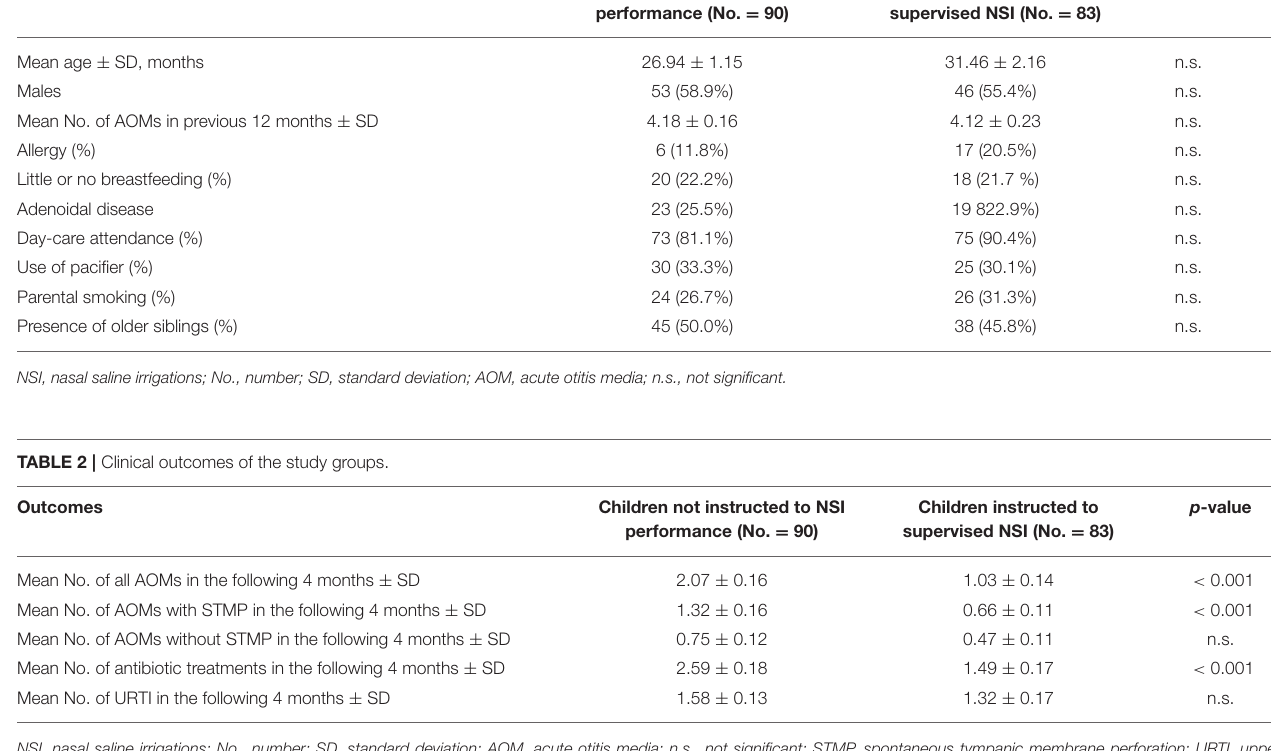
Characteristics